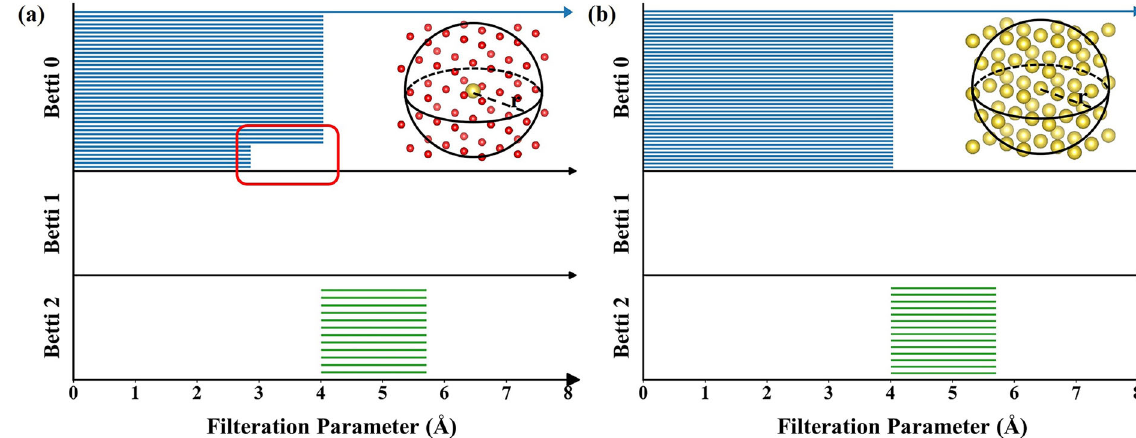
Fig. 2 Illustration of persistence barcodes of NaCl crystal speci fi c central-atom persistent homology. The central atom is Na with the surrounding atom is Cl ( a ) and is Na ( b ), respectively. Charts from top to bottom are Betti-0, Betti-1, and Betti-2 barcodes, respectively. The point cloud of each barcode is displayed.